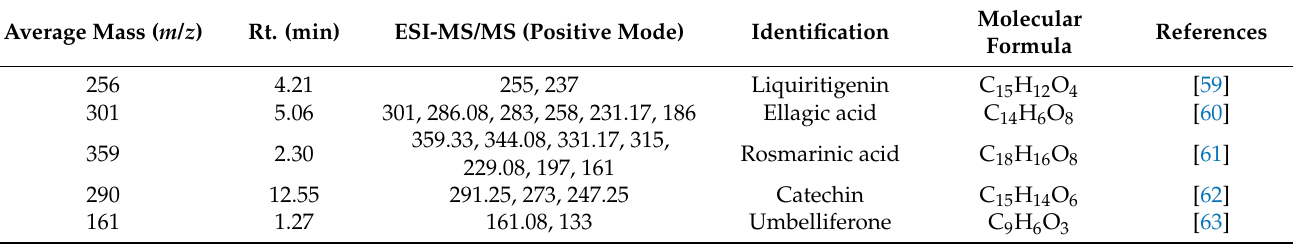
Table 4. LC-ESI-MS/MS main phenolic compound identification in ethanol extract of O. basilicum